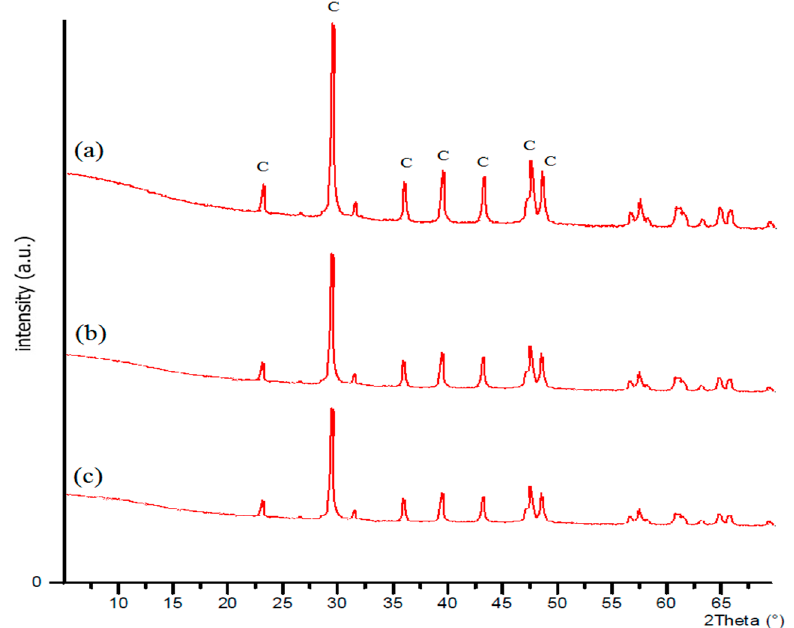
Figure 6. X-ray diffraction analysis of calcite: ( a ) feed; ( b ) optimum actual result; ( c ) optimum predicted result. C: Calcite.